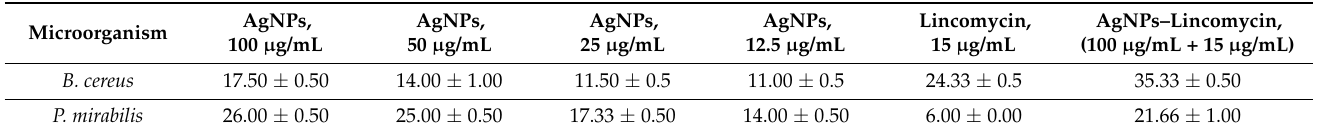
Figure 10. The inhibitory effects of different concentrations of AgNO 3 , AgNPs, lincomycin (MY), and AgNPs–lincomycin on ( A ) B. cereus and ( B ) P. mirabilis . Table 4. Anti-bacterial activity of lincomycin, AgNPs, and antibiotic and AgNPs mixture against bacterial